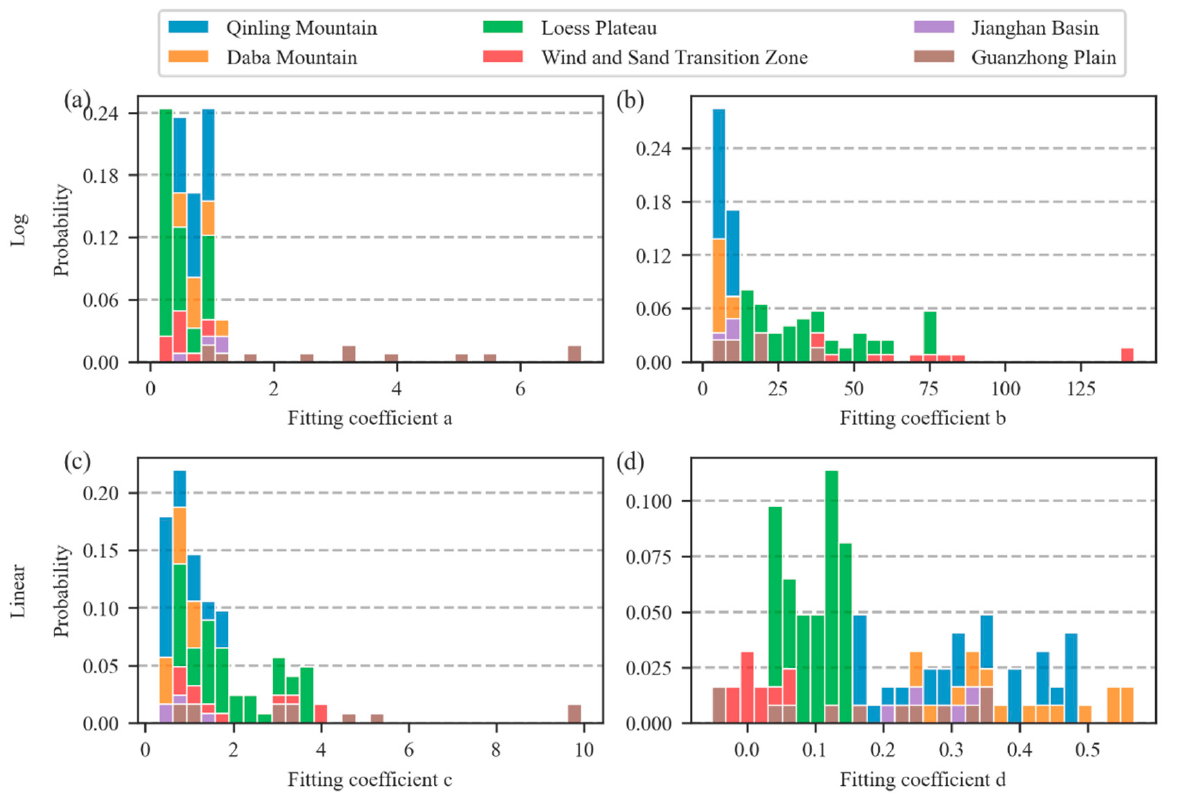
Figure 13. Relationship between the HDPS and mountain control area size and mountain undulation in each sample area of Shaanxi Province: ( a , b ) the coefficient distribution histogram of the exponential regression between the HDPS and the mountain control area size; ( c , d ) the coefficient distribution histogram of the linear regression between the HDPS and the mountain undulation, while coefficient c and d are the gradient and intercept of the regression line, respectively; six colors in the figures correspond to six geomorphological zones in Shaanxi